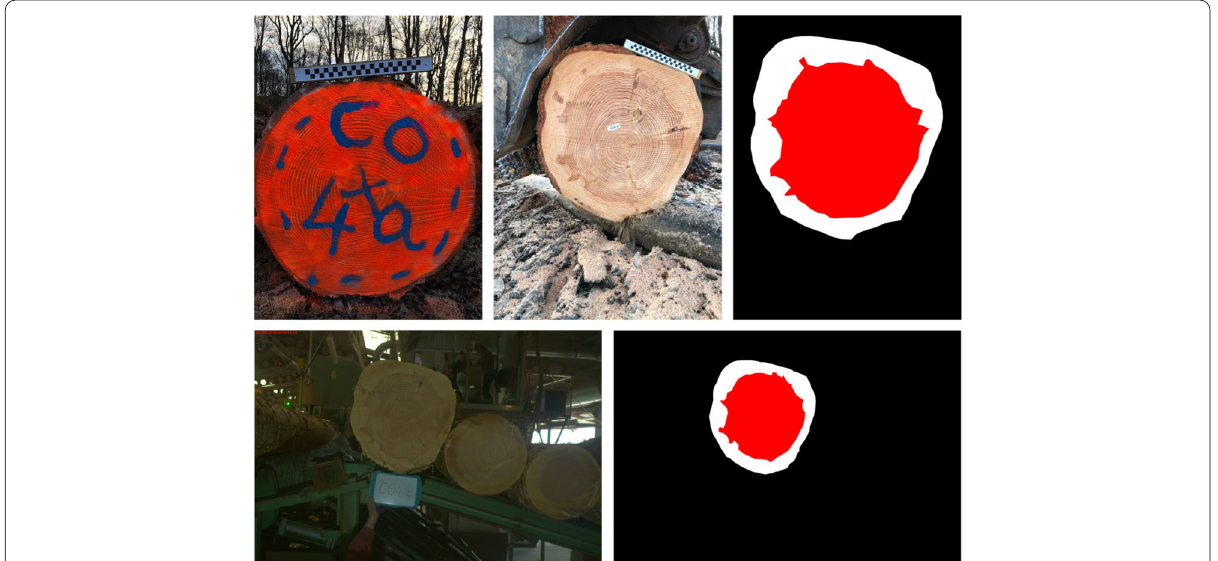
Fig. 5 Images of log C04a: Painted small end and large end images taken on the logyard, and corresponding manually segmented image (first row); large end image taken on the sawmill line and corresponding manually segmented image (second row). On the segmented images: The white area is the sapwood located between heartwood and bark; the red area is the